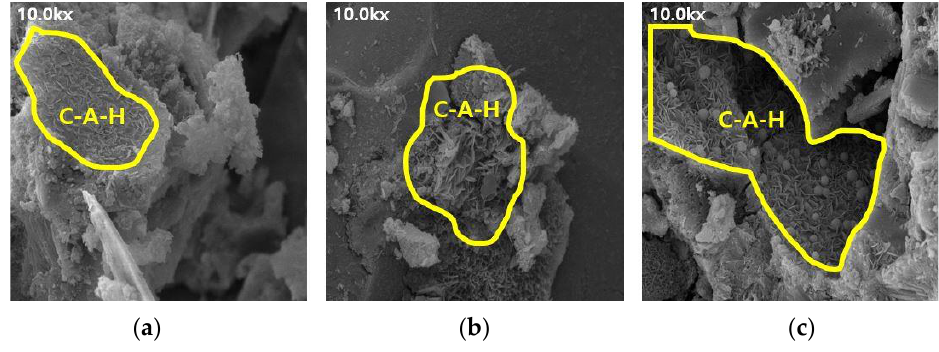
Figure 7. SEM results of BFS50: ( a ) 3, ( b ) 7, and ( c ) 28 d.